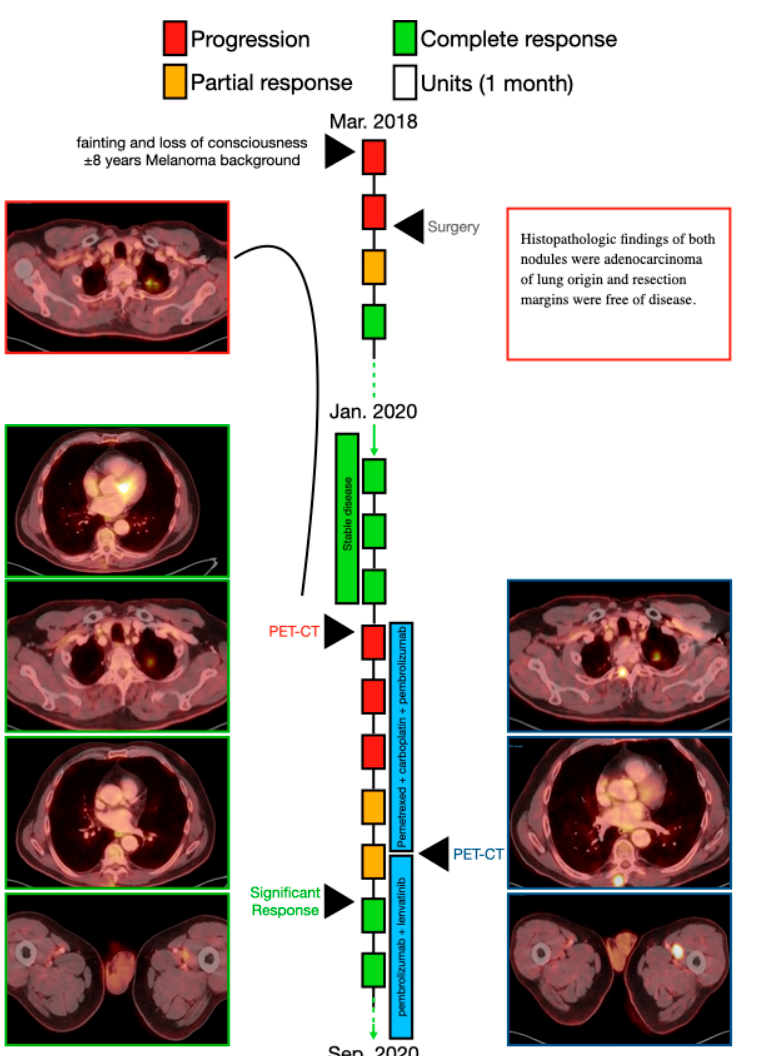
Figure 2. A schematic illustration of patient 2 ′ s timeline, between March 2018 (diagnosis of the disease) and September 2020, including the course of treatment and radiological follow-up. Each rectangle represents 1 month, and the response to treatment during each month is color-coded in green, red, or yellow, as described in the upper legend. Treatment administered in each timepoint is indicated by the blue rectangles. Radiological findings and additional landmarks are presented at relevant points throughout the